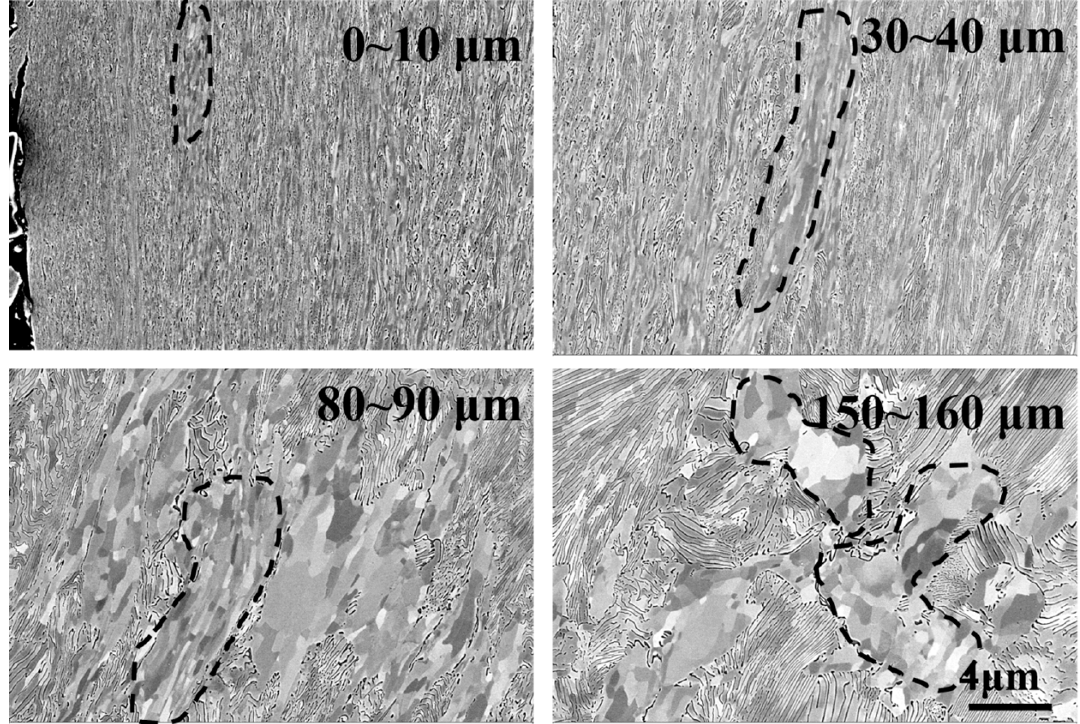
Figure 8. The SEM micrograph of wheel samples at different positions from the surface under a contact stress of 1200 MPa.